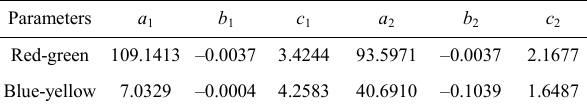
Table 1 Values of three parameters in (6).